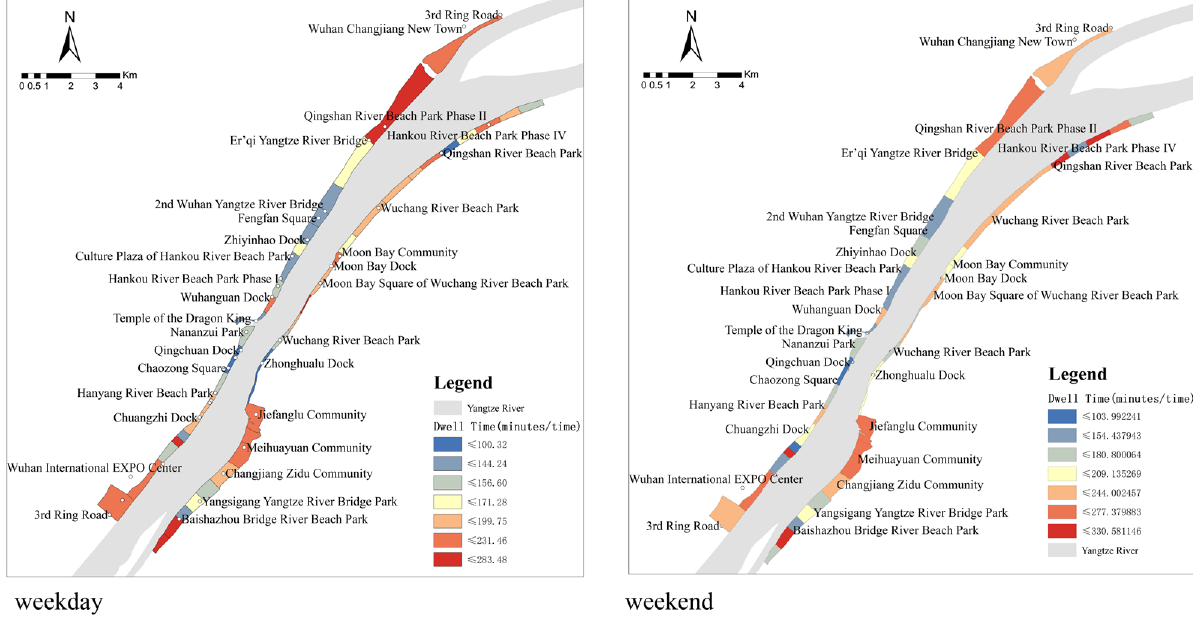
Figure 7. The dwell time distribution of the riverside area of Wuhan.